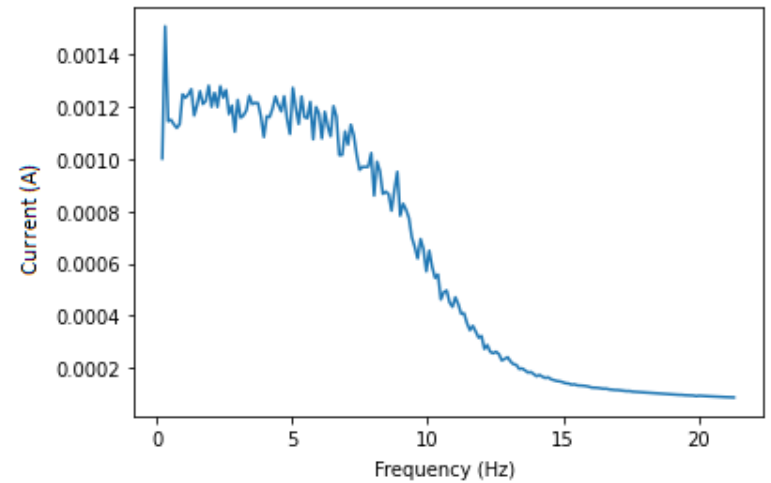
Figure 6. Current envelope of healthy IM, 250 Hz.